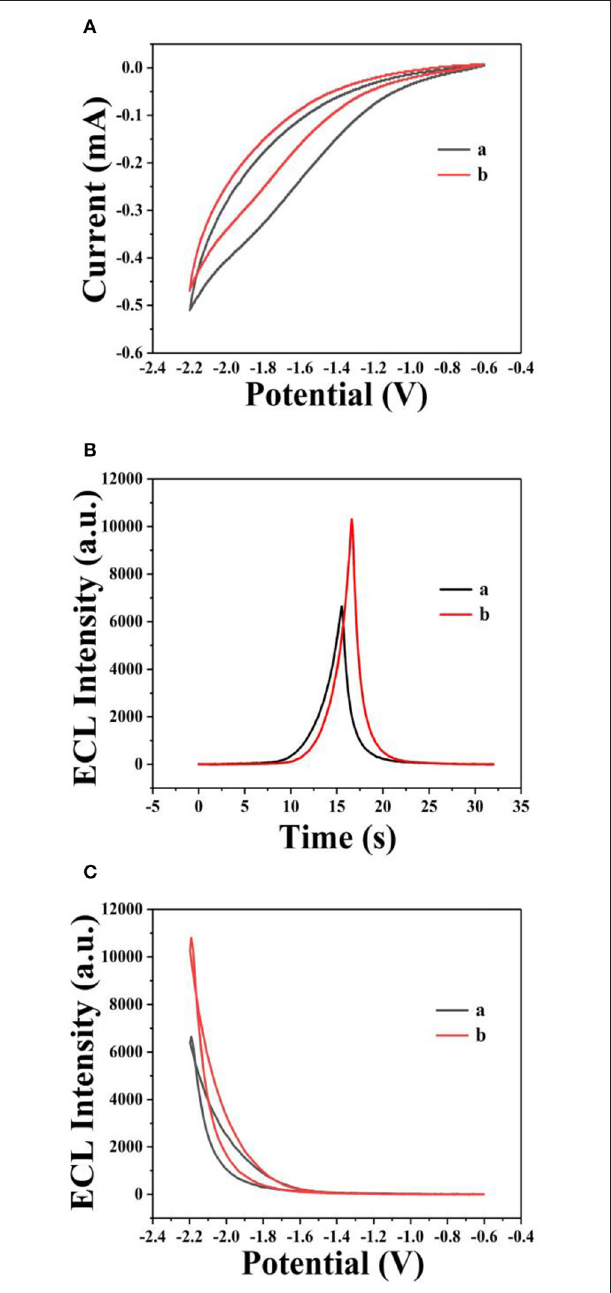
FIGURE 8 | Detection of sunset yellow by ECL using GQDs. Cyclic voltammograms (A) and ECL response (B) of the GQDs/GCE electrode at different concentrations of sunset yellow: (a) 25 µ M, (b) 2.5 µ M, (c) 0.25 µ M, (d) 0.025 µ M, and (e) 0.0025 µ M. (C) ECL responses of the biosensor to sunset yellow (25 µ M) over 10 successive cycles. Optimized conditions used for the reaction: GQDs, 0.1 mgmL − 1 ; co-reactant, 0.05M K 2 S 2 O 8 ; supporting electrolyte, 0.08M KCl; PBS buffer (pH 7); scan rate, 0.1 Vs − 1